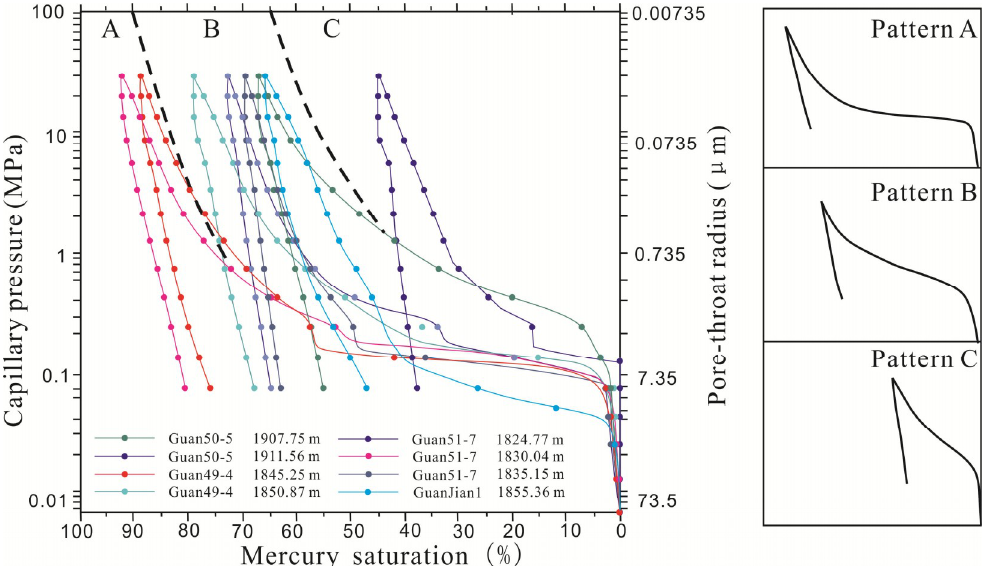
Figure 8. Intrusion and extrusion curves of the Pressure mercury method and the three patterns of intrusion and extrusion curves.